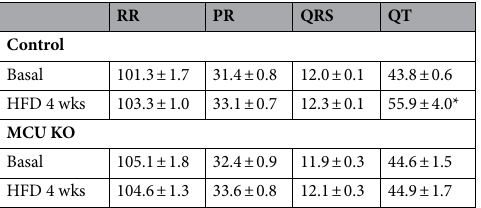
Table 1. QT prolongs with HFD diet in control mice but not MCU KO mice. Intervals are in milliseconds, ± SEM, n = 4 each group, *p < 0.05 compared to